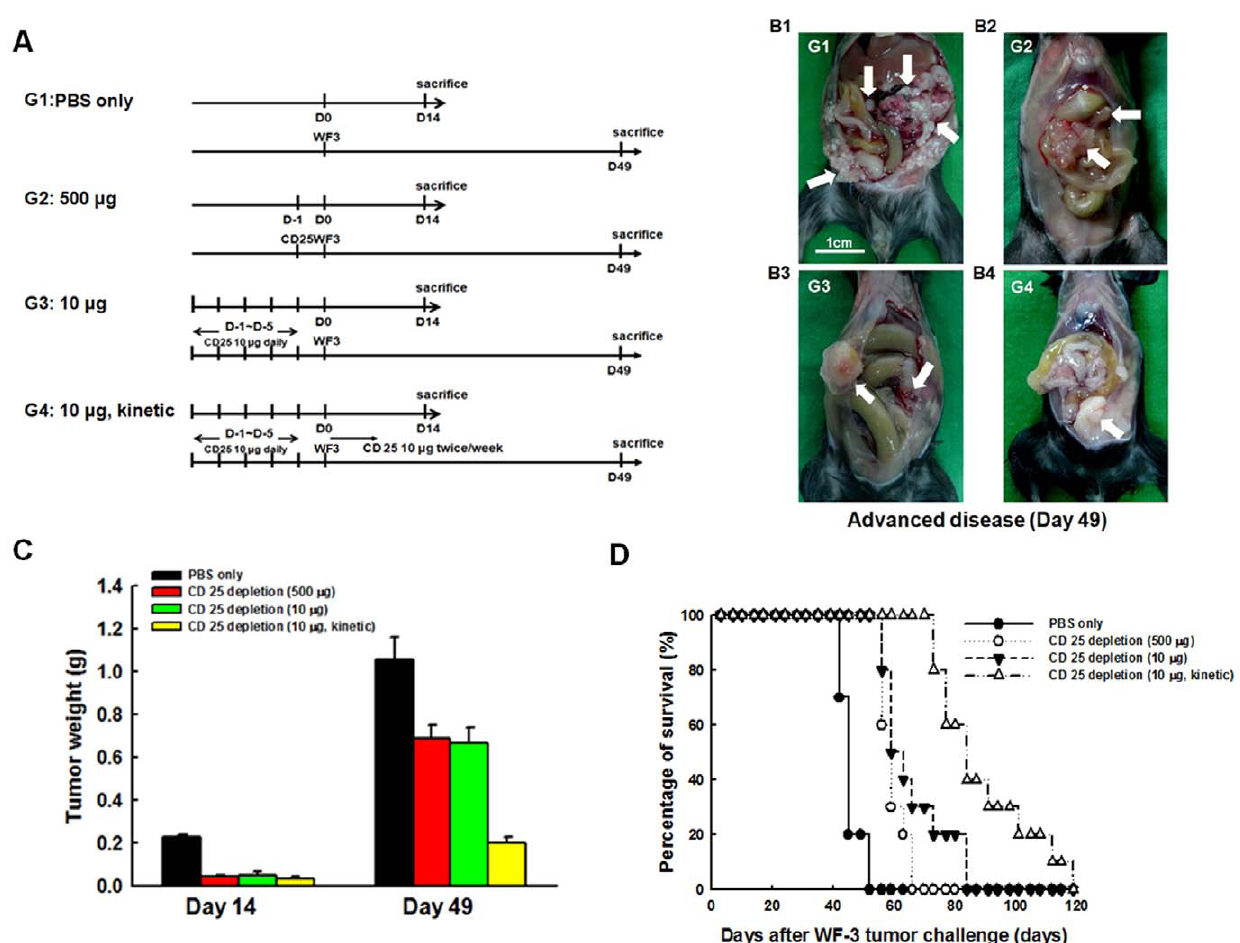
Figure 5. Tumor growth of WF-3-challenged mice treated with PBS or CD25 monoclonal antibody. ( A ) Diagrammatic representation of the different treatment protocols of CD25 monoclonal antibody. ( B ) Representative figures of mice treated with PBS and various protocols of CD25 monoclonal antibody. B1, PBS only; B2 (sequential high dose CD25 Ab group), 500 m g of CD25 monoclonal antibody for 1 day before WF-3 tumor challenge; B3 (sequential low dose CD25 Ab group), 10 m g of CD25 monoclonal antibody for 5 days before WF-3 tumor challenge; B4 (kinetic low dose CD25 Ab group), 10 m g of CD25 monoclonal antibody for 5 days before WF-3 tumor challenge and 10 m g of CD25 monoclonal antibody twice per week continuously after WF-3 tumor challenge (arrows: WF-3 tumor masses). ( C ) Intra-peritoneal tumor weights of mice treated with PBS or CD25 monoclonal antibody. Note : The total tumor weights of various CD25 Ab depletion groups were lower than those of PBS-treated group mice on day 14 after WF-3 tumor challenge. However, the intra-peritoneal tumor weights of the kinetic low dose CD25 Ab group were lowest compared to the other groups on day 49 after tumor challenge. ( D ) Survival curves of mice treated with PBS or CD25 monoclonal antibody. Note : The in vivo CD25 antibody depletion regardless of groups extended survival of the mice compared to those treated with PBS only. However, the kinetic low-dose CD25 Ab group had the longest survival time after WF-3 tumor challenge.